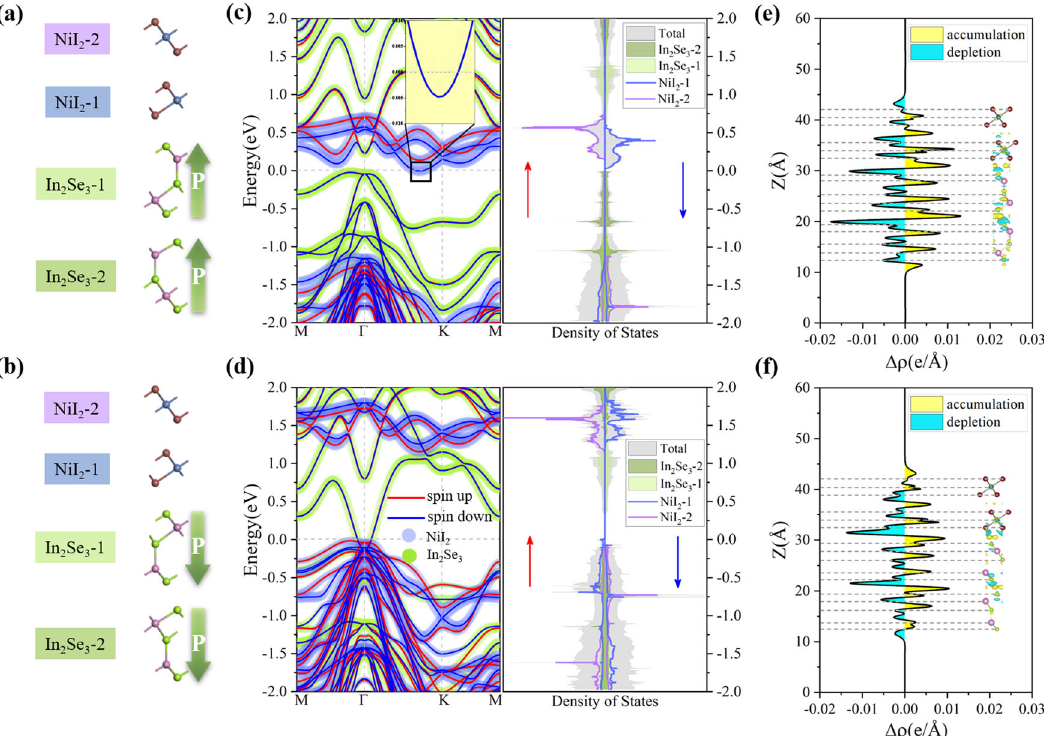
Fig. 3 Basic properties of bi-NiI 2 /bi-In 2 Se 3 heterostructure. a , b Structural diagrams, c , d calculated band structures and DOSs, and e , f differential charge distributions of bi-NiI 2 /bi-In 2 Se 3 heterostructure in the P ↑↑ and P ↓↓ con fi gurations, respectively. The red and blue lines in band structures represent spin-up and spin-down states,